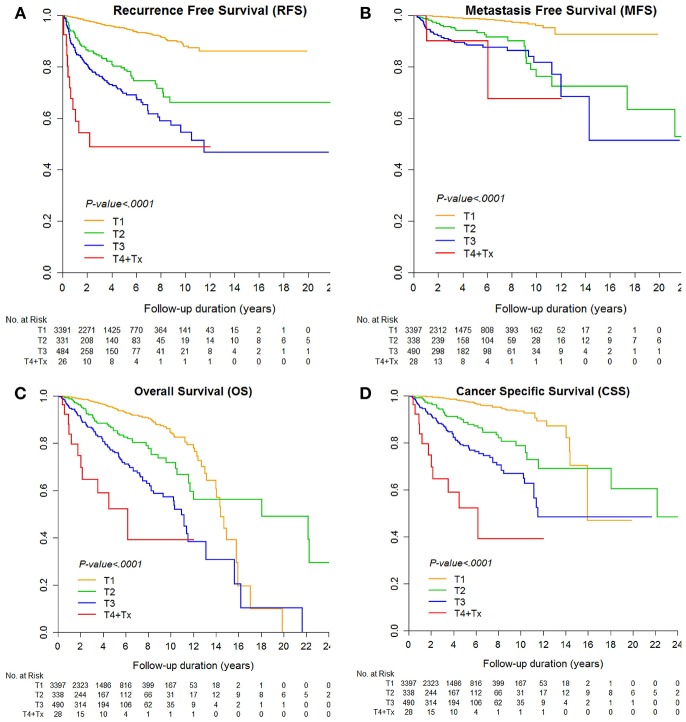
Kaplan-Meier curve for (A) recurrence-free survival, (B) metastasis-free survival, (C) overall survival, and (D) cancer-specific survival according to pathological T stages.